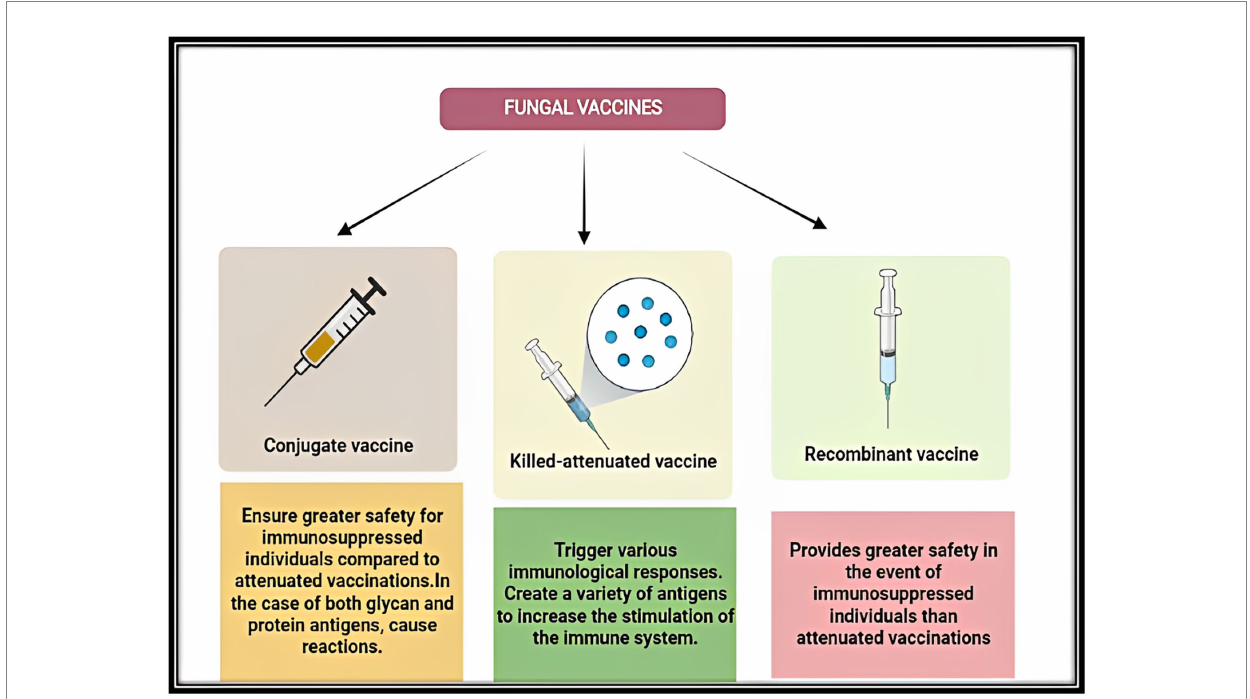
FIGURE 5 Diagrammatic representation of the advantages of three different groups of fungal vaccines viz. : Conjugate vaccines, Killed-attenuated vaccines and Recombinant vaccines under